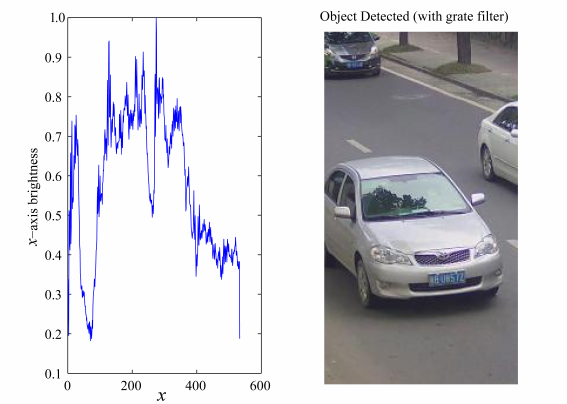
Fig. 12 Horizontal axis’ brightness values and selected bus (with grate filter) according to Fig. 10.